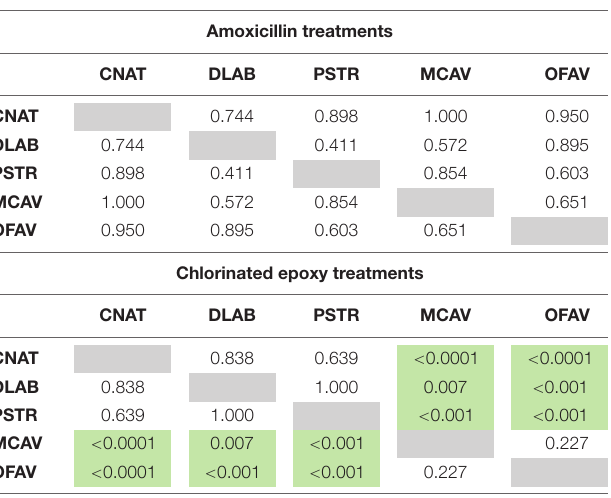
TABLE 4 | Significant differences ( p-values ) in modeled treatment effectiveness among species under two different treatment types (amoxicillin and chlorinated